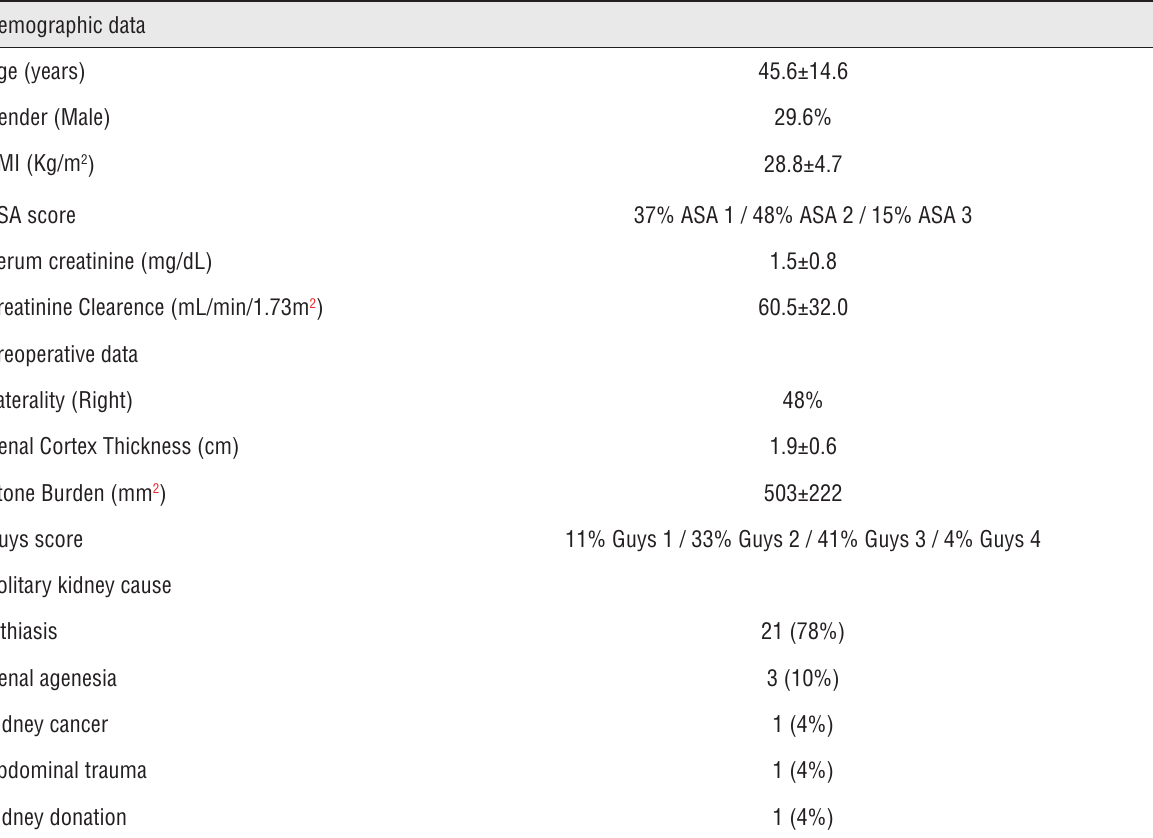
Table1 - Demographic and preoperative